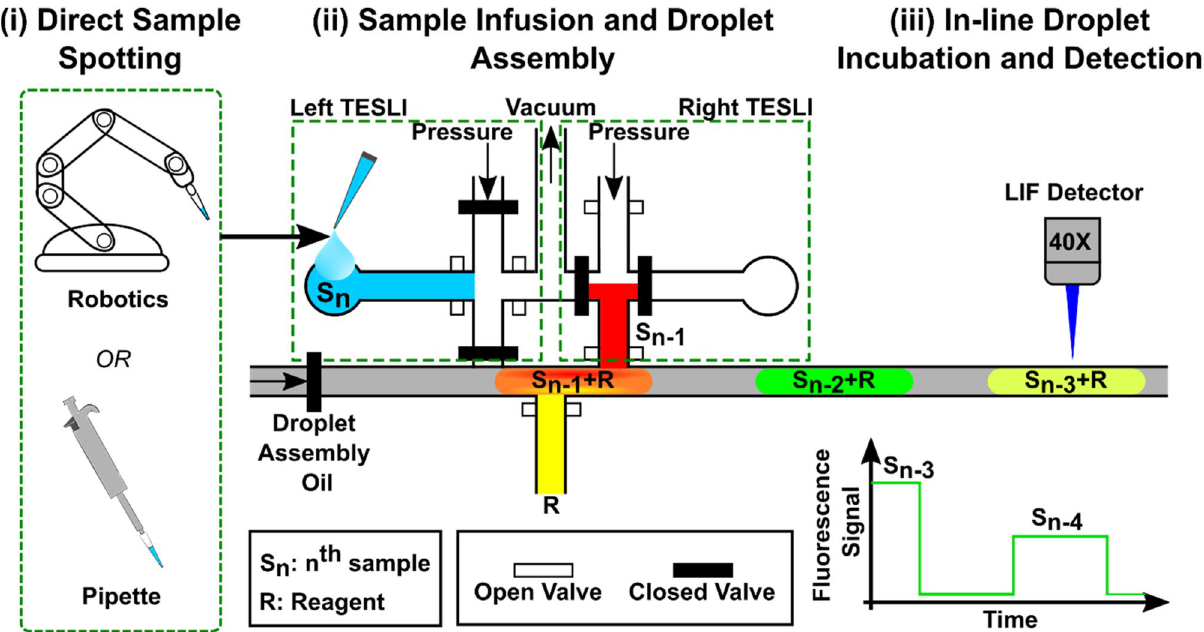
Figure 1. Streamlined workflow enabled by TESLI (Tubing Eliminated Sample Loading Interfaces) and integrated droplet device. The streamlined workflow is composed of ( i ) direct sample spotting, ( ii ) sample infusion and droplet generation enabled by dual TESLIs, and ( iii ) in-line droplet incubation and detection. ( i ) Both robotics and pipetting can be employed to directly spot ( ii ) a new sample (S n ) onto an open-to-atmosphere inlet port of TESLI of the integrated droplet device. As S n is infused into the device through the left TESLI by opening the microvalves connected to a vacuum source, the previously loaded sample (S n−1 ) in the right TESLI and a reagent (R) in a reagent channel are injected to form a nanoliter droplet by opening the microvalves connected to pressure sources. The dual TESLIs can alternate their operations, thereby achieving simultaneous sample switching and droplet generation. Once assembled, every droplet is propelled by pressurized droplet assembly oil to flow orderly downstream for ( iii ) in-line droplet incubation and in-line fluorescence detection in the same order as it is generated. As every droplet sequentially flows through the detection zone, a custom laser induced fluorescence (LIF) detector measures its emitted fluorescence signal, resulting in a fluorescence trace from all droplets as a function of time for visualization and